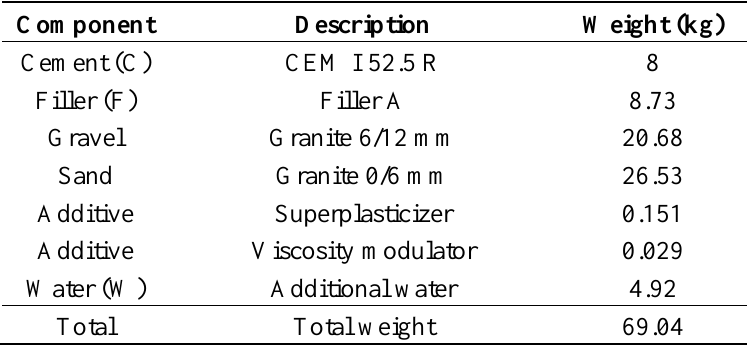
Table 1. Composition of the reference